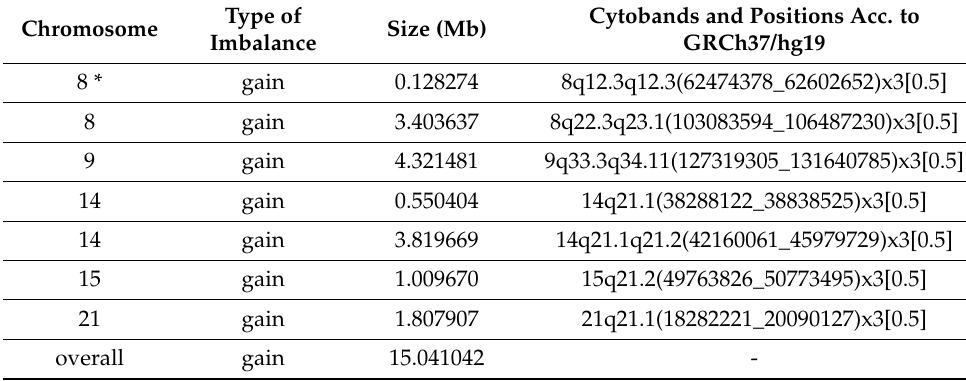
Table 3. Summary of imbalances due to sSMC presence as detected by aCGH. Type of Cytobands and Positions Acc. Chromosome Size (Mb) Imbalance